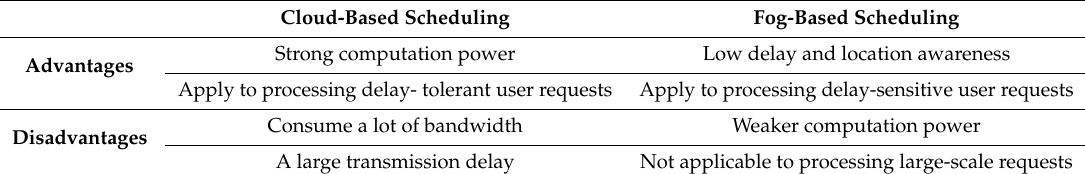
Table 1. Di ff erences between cloud-based scheduling and fog-based scheduling.